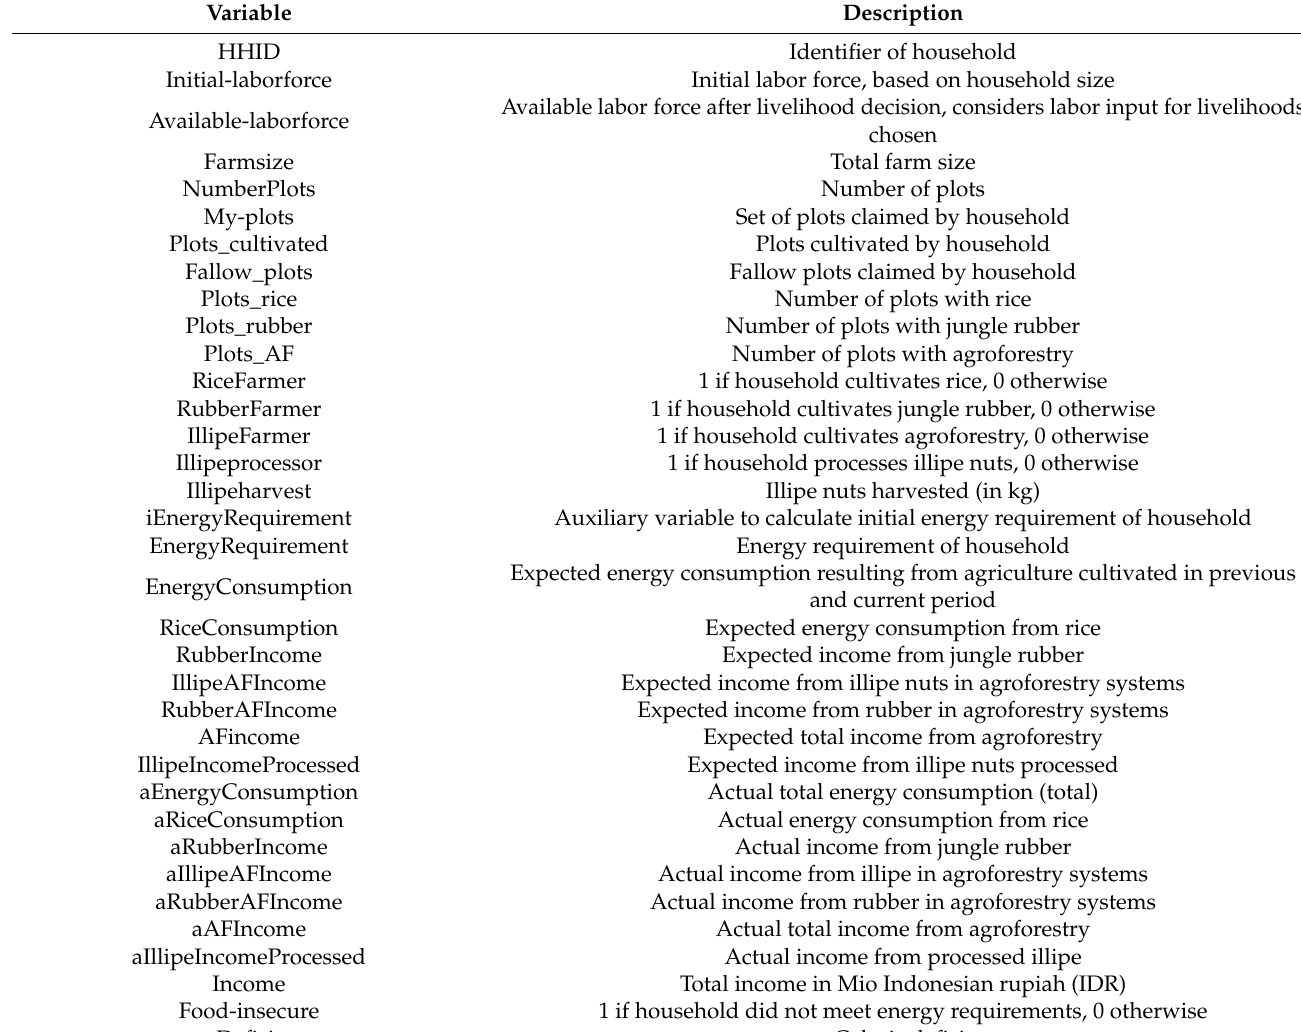
Table 1. Model description: farmer agent